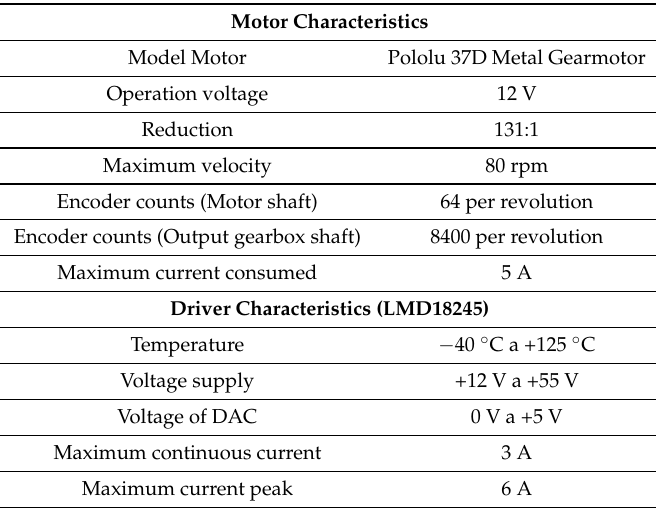
Table 6. Experimental